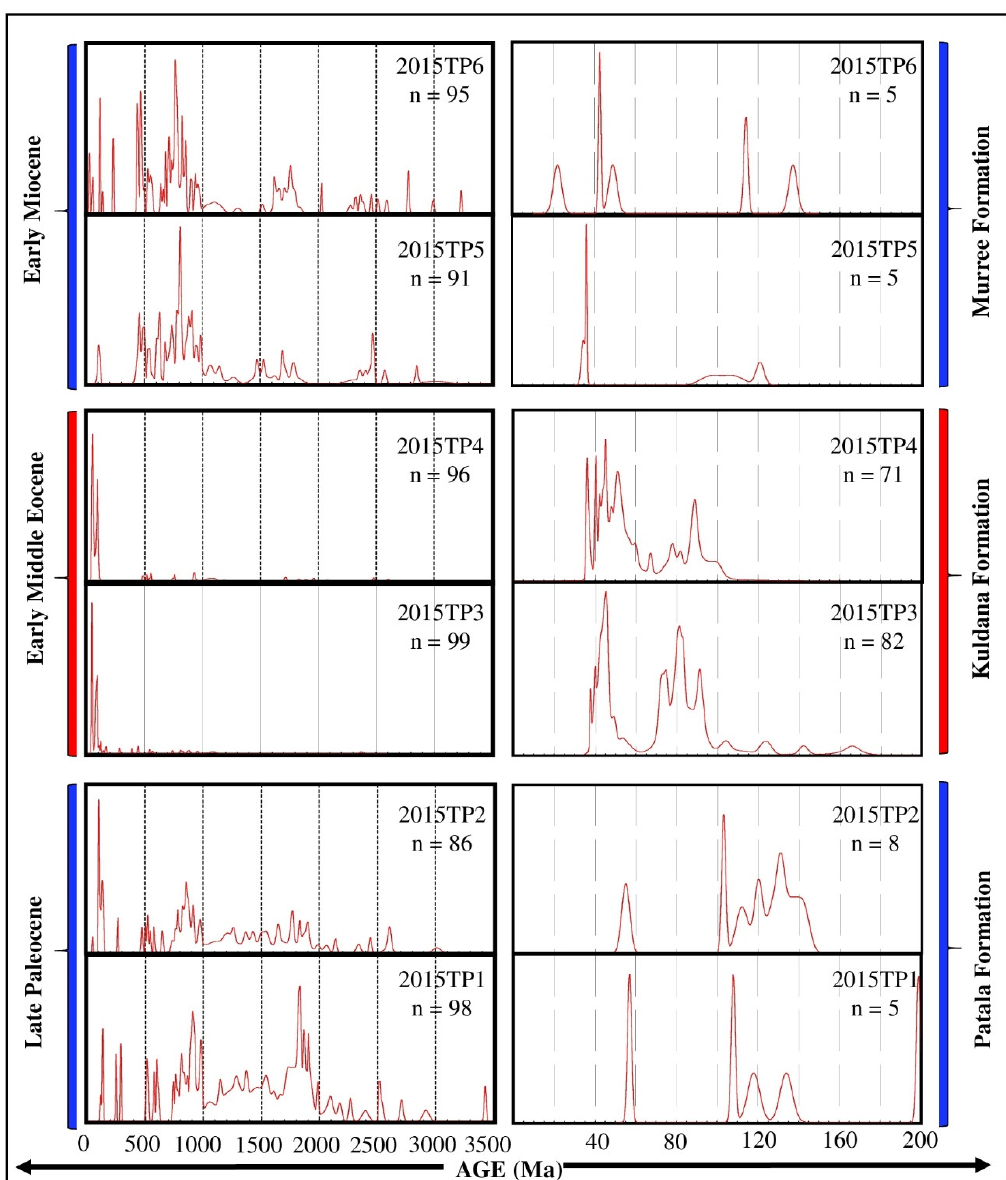
Figure 4. U-Pb probability density plots for studied samples of Late Paleocene Patala Formation, Early middle Eocene Kuldana Formation and Early Miocene Murree Formation, representing the Kotli section, Kashmir Basin, northwestern Himalaya, Pakistan.